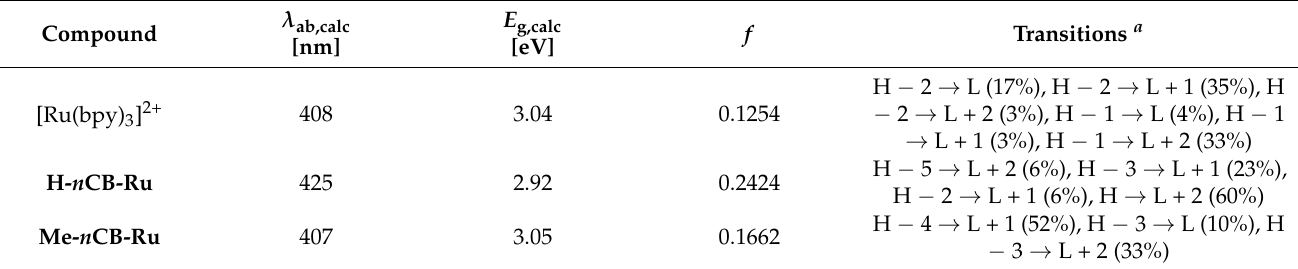
Table 4. Estimated absorption data from TD-DFT calculations.